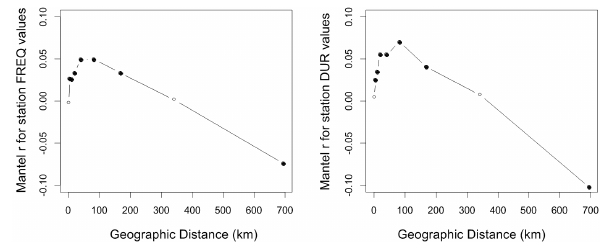
Fig. 6. Mantel correlograms of FREQ and DUR for gauging stations on intermittent segments in nine distance classes. The plots indicate the Mantel r values for each distance class plotted against the mean separation of gauging stations in the class. Solid dots indicate sig- nificant Mantel r values ( p < 0.05) after Bonferroni correction.